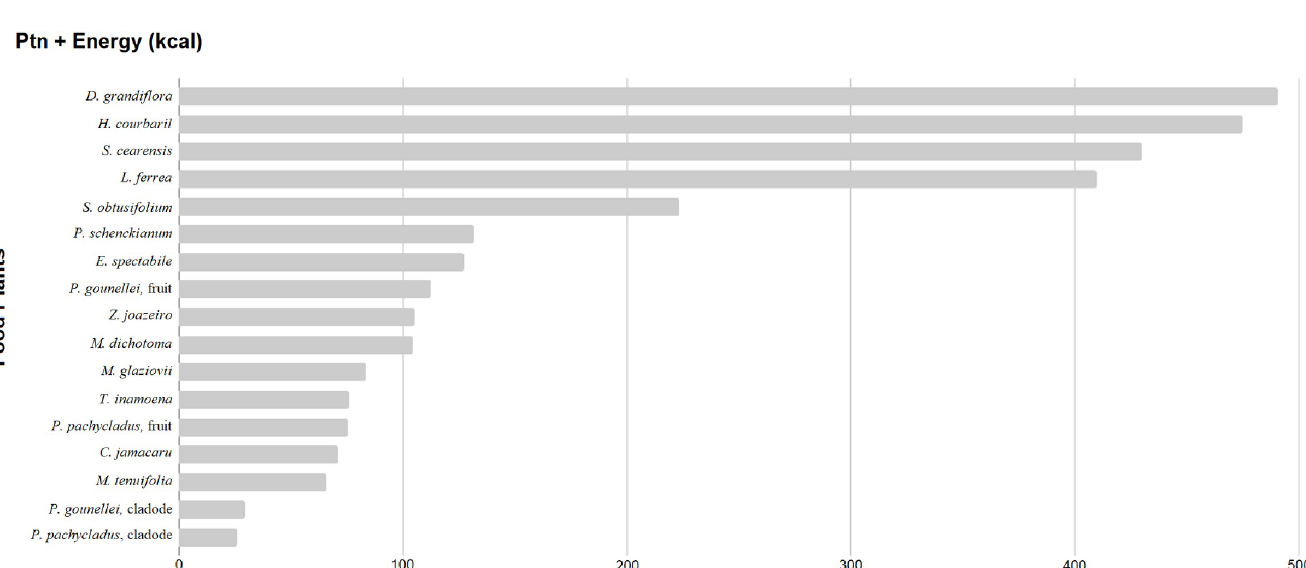
The main objective of this SR was to identify plants occurring in the Caatinga that could be strategic in the promotion of FNS. For this, we listed and characterized the species occurring in the biome and produced a list of strategic plants with nutritional data. Based on our analysis, we highlighted the energy and protein potential of native legumes.